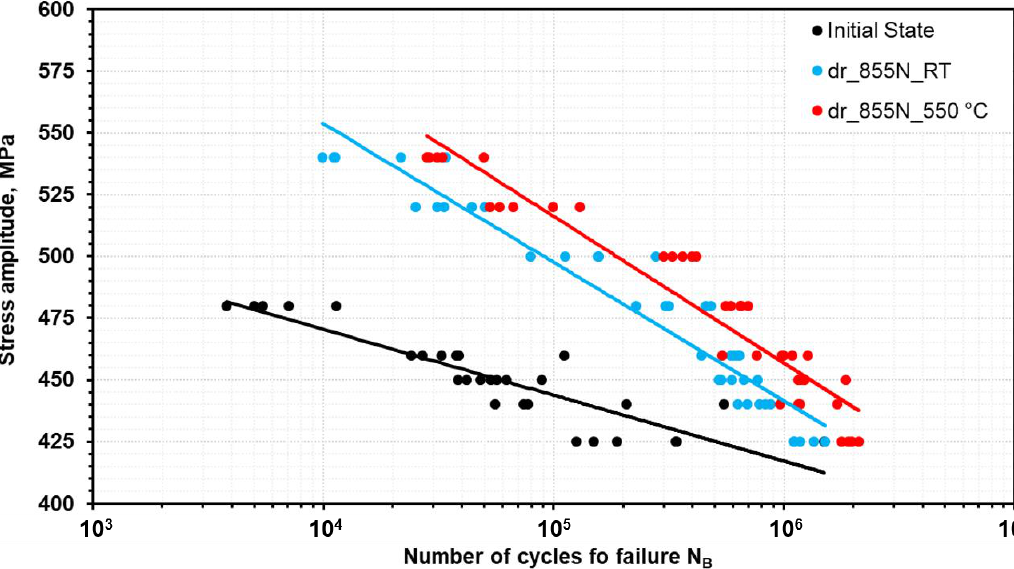
Figure 5. S-N curve of the specimen deep rolled at 550 °C applying a deep rolling force of 855 N. Data of the initial state condition and of the condition deep rolled at RT using a deep rolling force of 855 N were (partly) recompiled from [39].